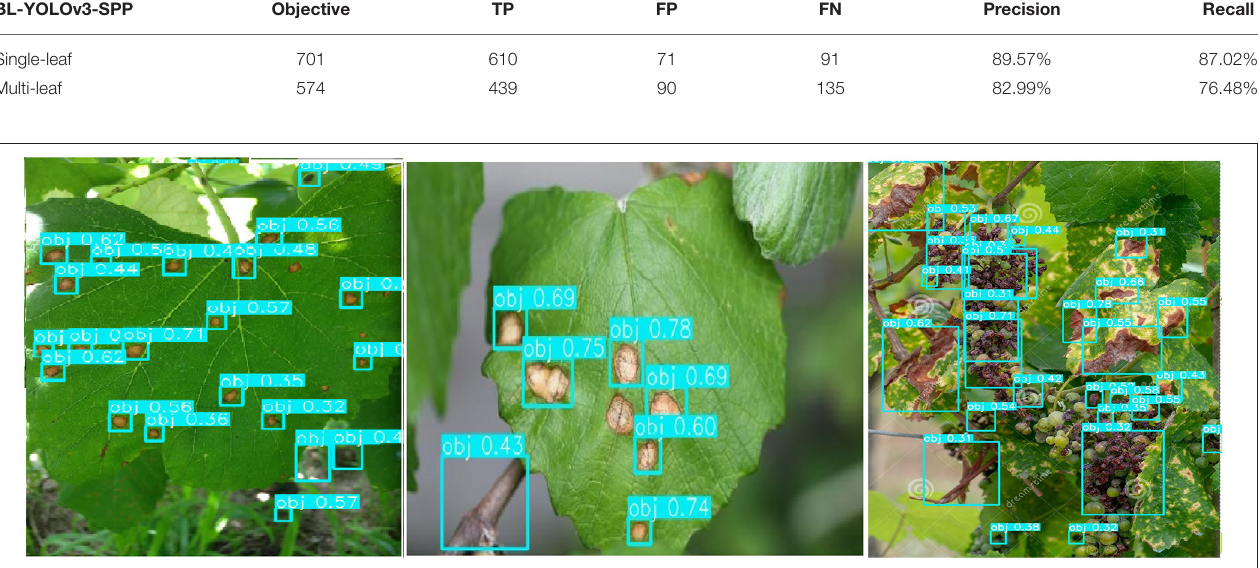
FIGURE 14 | Detection results of grapevine leaf black rot with complex background.